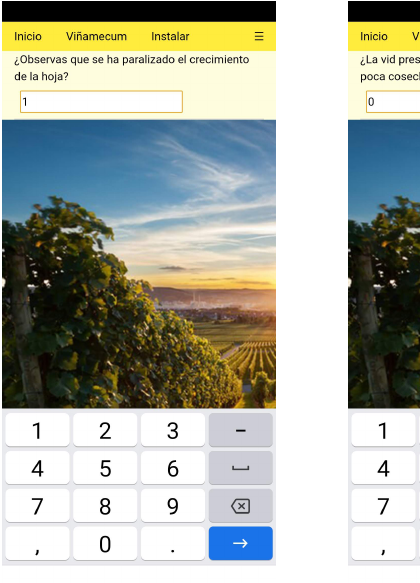
Figure 1. Screenshots of “Viñamecum” for the diagnosis of a disease. Table 2. Conclusion and steps taken by “Viñamecum” from the data provided by the user. Steps Performed in the